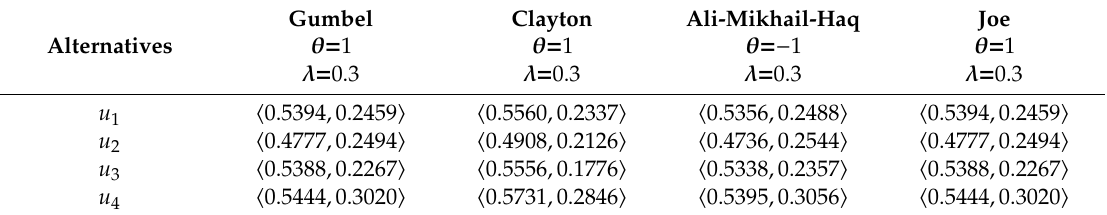
Table 6. The aggregation results using intuitionistic fuzzy Archimedean copula weighted arithmetic aggregation ( IFACWAA w )